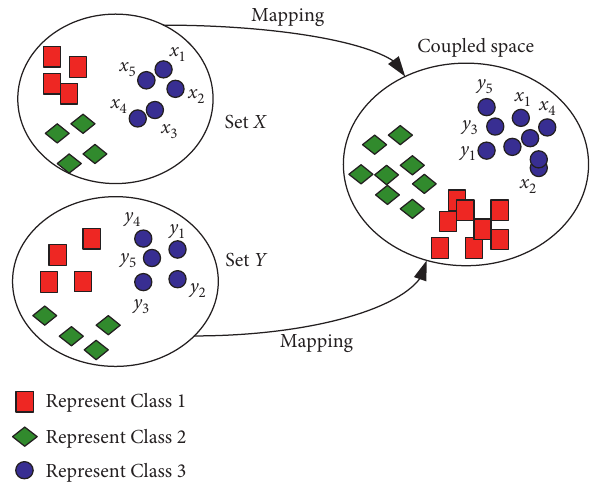
Figure 1: The coupled metric mapping supervised by category labels. There are thirteen samples in set X and set Y , respectively; all these samples belong to three categories, denoted as square, rhombus, and circle. In set X , sample x 1 is close to sample x 2 , away from sample x 4 . However, sample x 1 is close to sample x 4 , away from sample x 2 in the coupled space. Although the samples within the same category are grouped together, the distribution rela- tionship between the samples is not maintained, which sometimes affects the image-matching